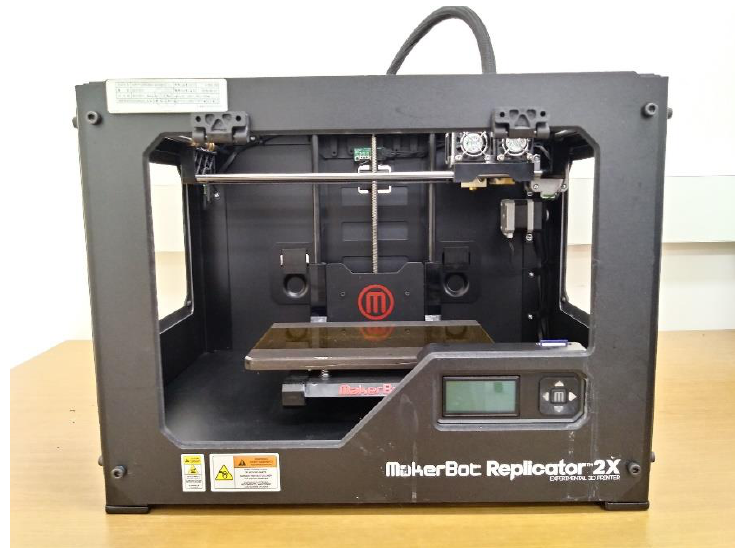
Figure 3. Fused deposition modelling (FDM) 3D printer. Figure 3. fused deposition modelling (FDM) 3D printer. Table 1. Printing conditions for specimens.